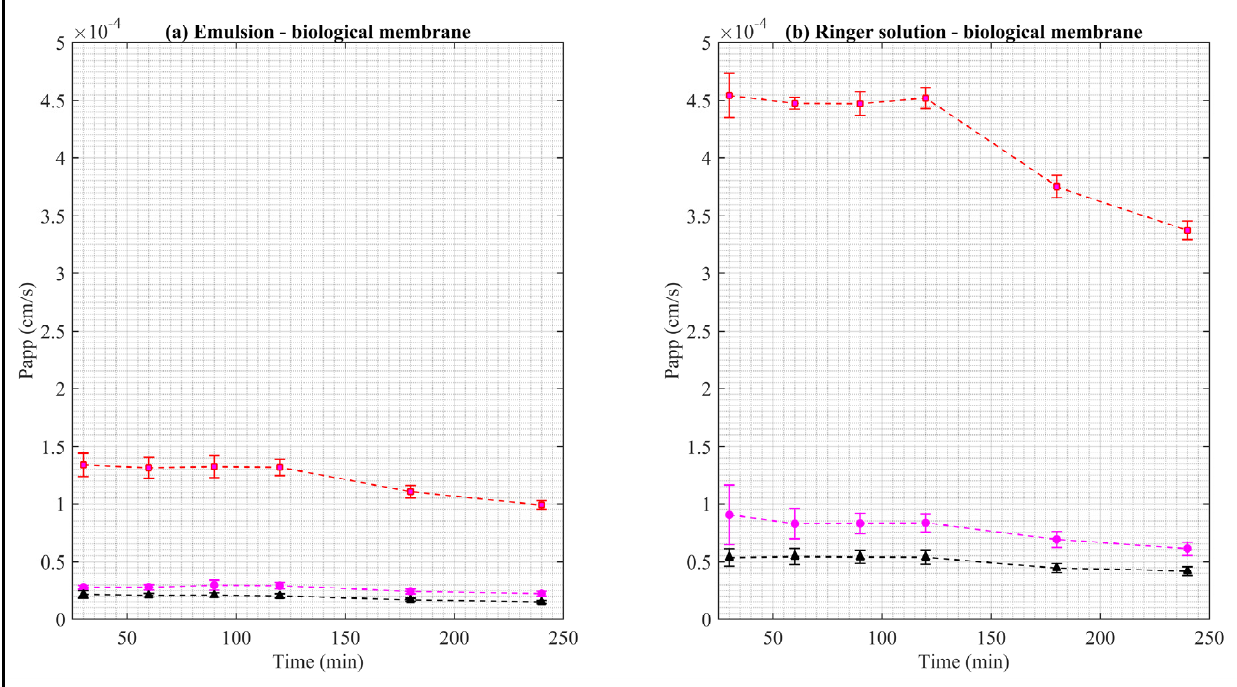
Figure 6. Apparent permeability of EB in the biological membrane. Red squares represent EB–ALG microparticles, black triangles represent EB–SOL microparticles, and magenta circles represent free EB. ( a ) Represents the emulsion as donor media with biological membrane, and ( b ) represents the Ringer solution as donor media with biological membrane. Values represent the mean with standard deviation ( n = 5). Table 2. Apparent permeability results in biological